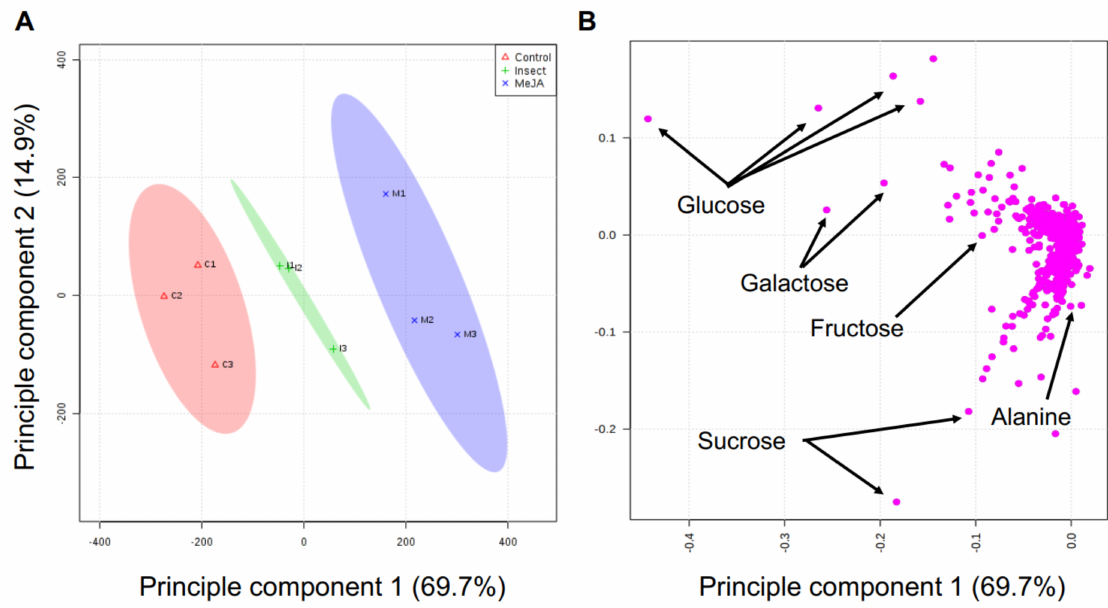
Figure 3. Principle component analysis ( A ) score and ( B ) loading plots derived from non-targeted metabolite profiling of Brassica napus with the control plants, MeJA-treated plants, and insect-feeding plants. The shaded areas in ( A ) represents 95% confidence regions. The pink dots indicated by arrows in ( B ) represent discriminating biomarkers among various